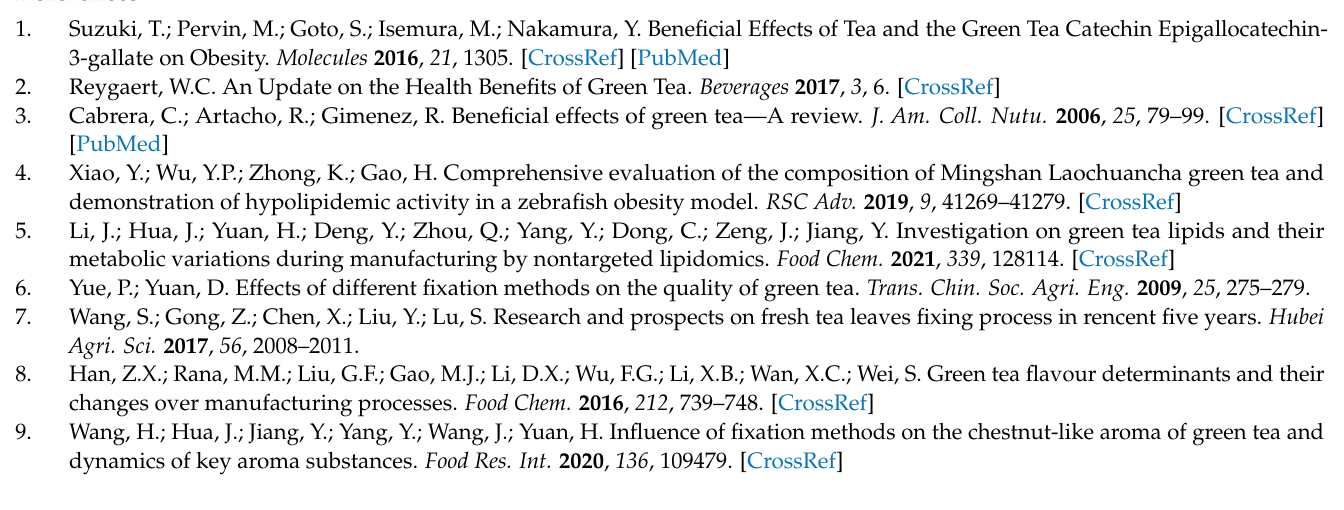
SGT; Table S2: VIP values in OPLS-DA model and p values of volatiles compounds; Table S3: Contents of chemical compounds in PGT and SGT; Table S4: VIP values in OPLS-DA model and p values of chemical